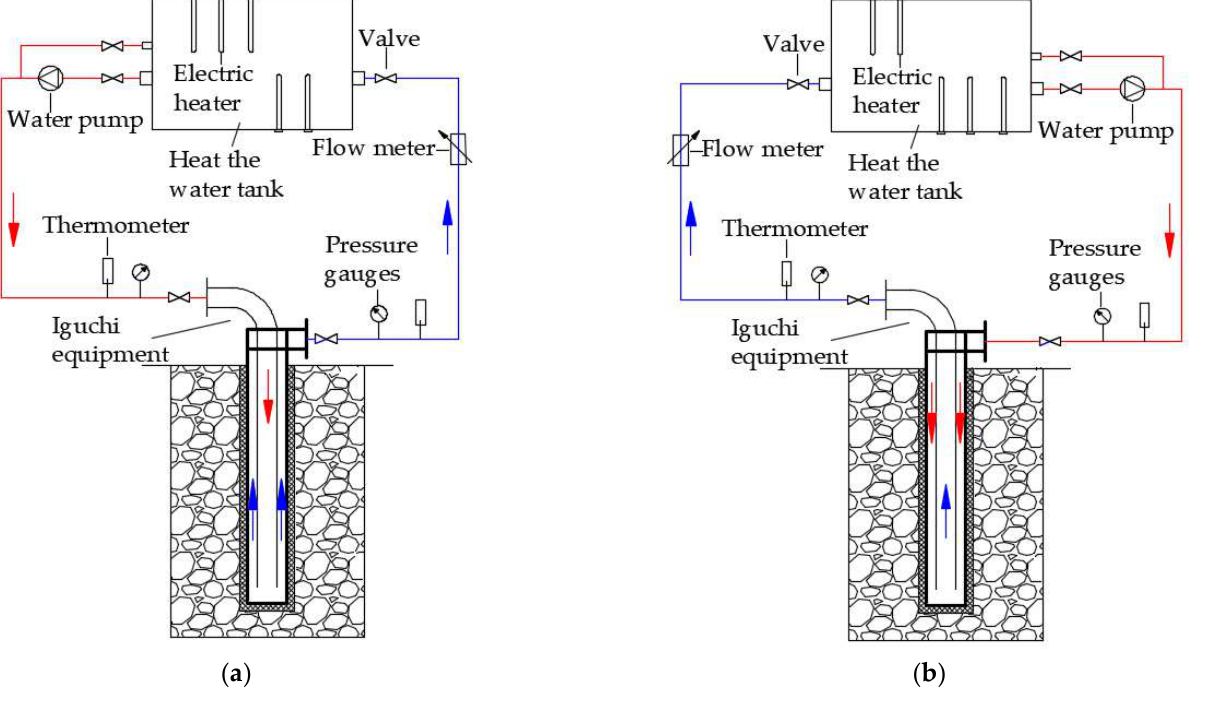
Figure 11. Schematic diagram of the thermophysical properties test. ( a ) The “inner tube in and outer tube out” configuration. ( b ) The “outer tube in and inner tube out” configuration.